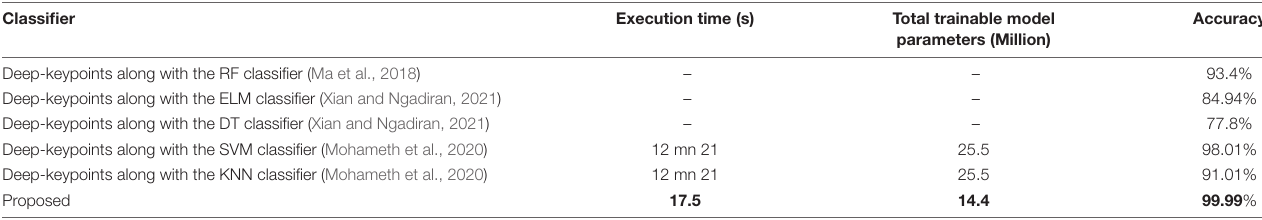
Accuracy parameters (Million)